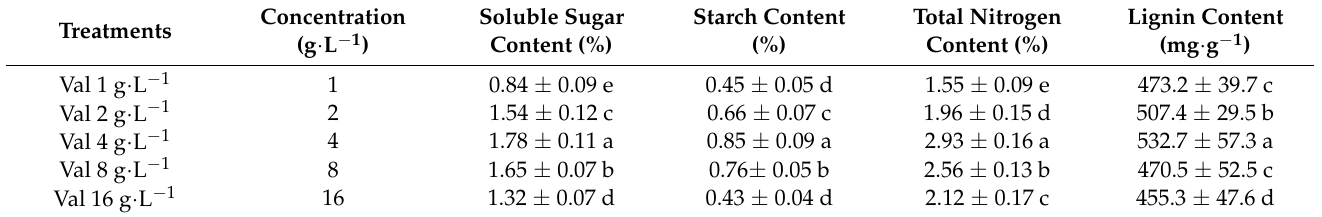
Table 4. Effects of different concentrations of valine on the content of carbon and nitrogen metabolites and